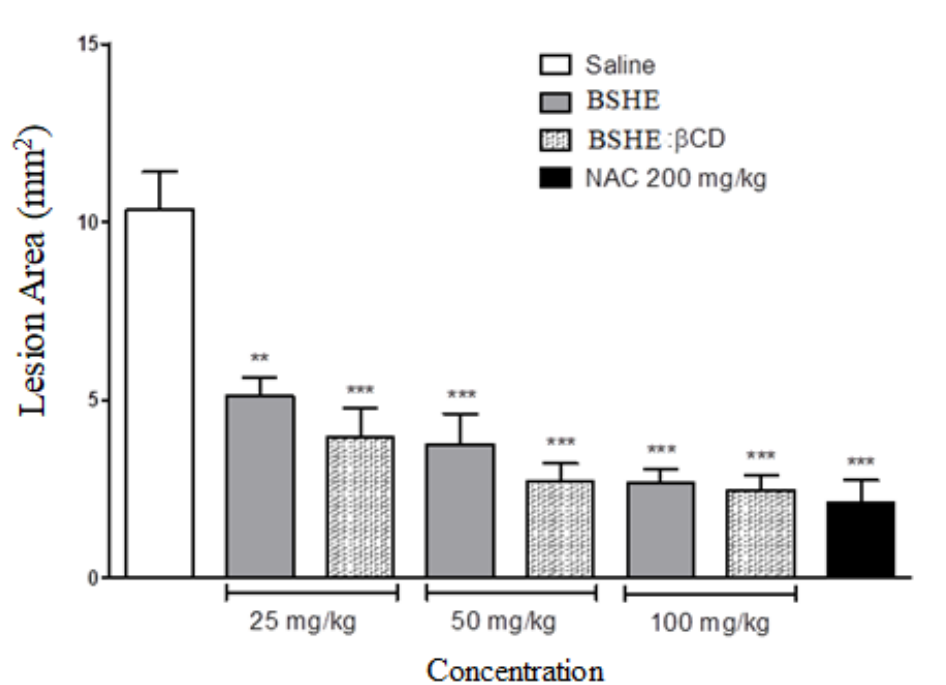
Figure 8. Analysis of gastroprotective activity BSHE: β -CD inclusion complexes in gastric lesions induced by I/R in rats. BSHE and BSHE: β -CD inclusion complexes were used at doses of 25, 50, and 100 mg/kg. For negative control, saline was used, and for positive control, N-acetylcysteine (200 mg/kg) was used. Data are expressed as mean ± E.P.M., ** p < 0.01 and *** p < 0.001, compared to control (ANOVA, followed by Tukey’s